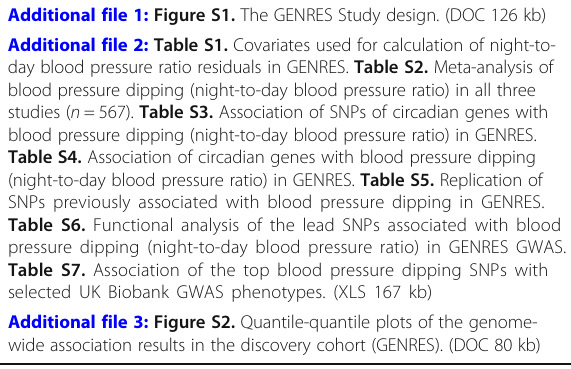
Additional file 1: Figure S1. The GENRES Study design. (DOC 126 kb)